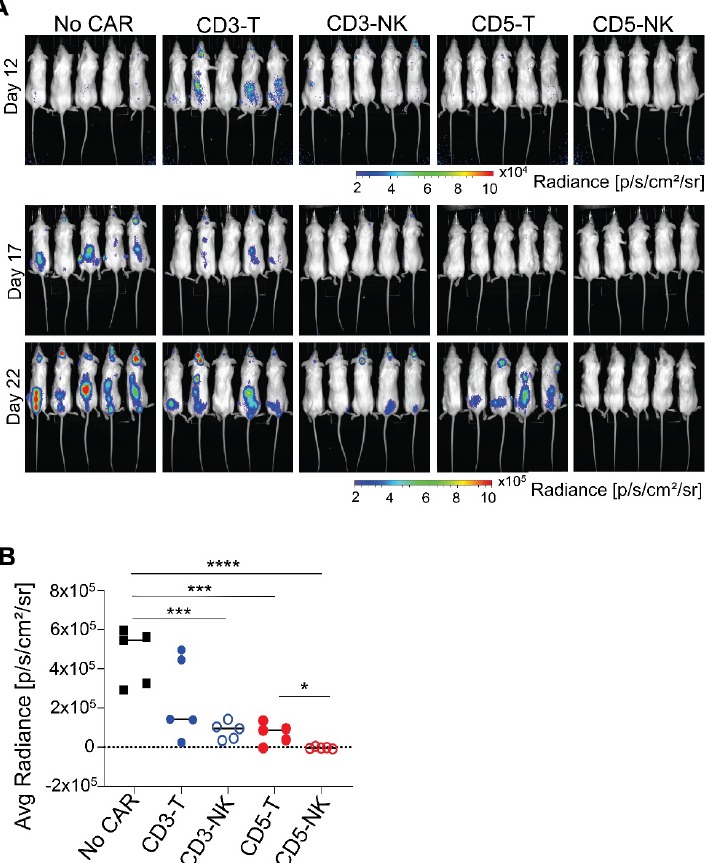
Figure 4. Elimination of Jurkat cells in a diffuse xenograft mouse model treated with CD3 and CD5 CAR − T and CAR − NK NK cells. ( A ) IVIS imaging of tumor xenografts in NSG mice at different time points after i.v. injection of 1 × 10 6 Jurkat cells (Day 0) and NK cells expressing different CAR constructs at day 3 and 8. ( B ) Quantitative analysis of average radiance measured in different groups of mice injected with indicated CARs was compared to that of vector control NK-92 injected mice at 22 days post tumor injection. Each dot represents an individual mouse. Unpaired t -test, n = 5 per group, p < 0.05 (*), p < 0.001 (***), p < 0.0001 (****). This experiment is representative of two independent experiments with similar results.